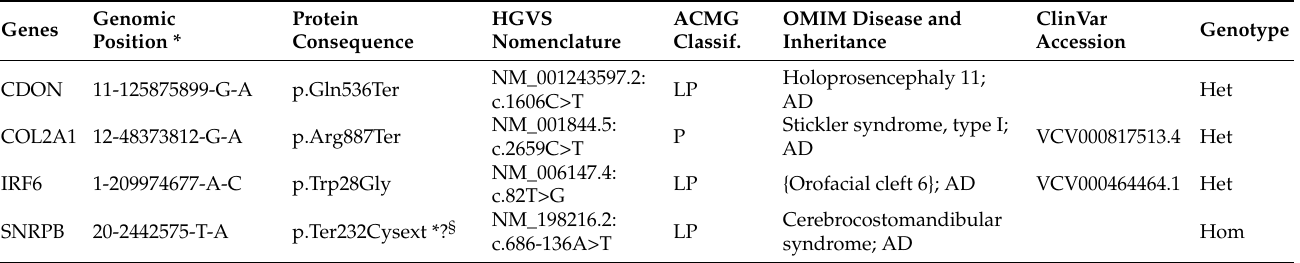
Table 4. Pathogenic and likely pathogenic variants of cases identified in genes associated with syndromes involving